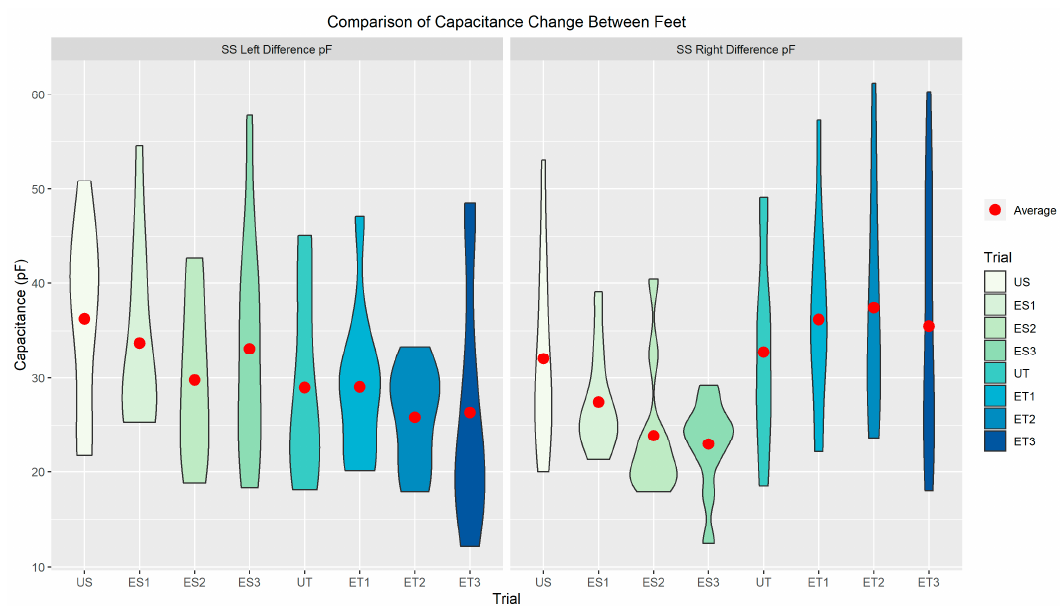
Figure 7. Spread and averages peak angles for each foot across every trial; note that positive and negative changes occur respective to the trial with negative values indicating movement of ankle into PF and positive values indicate movement of ankle into DF.